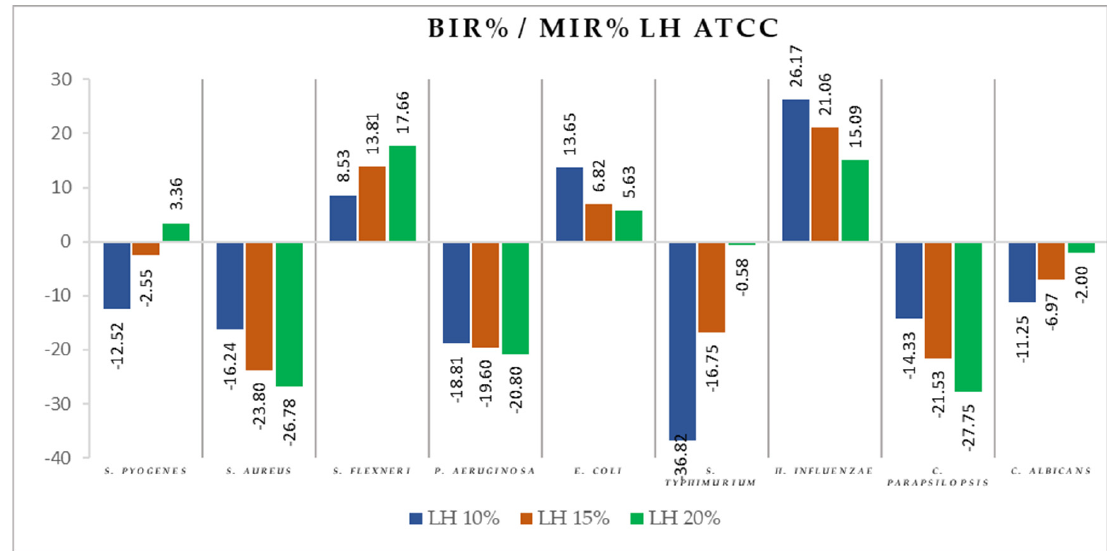
Figure 7. LH antimicrobial activity (expressed as BIR%/MIR%) on ATCC strains. Comparing the BIR percentages, the most sensitive ATCC strains in the case of the MH samples were H. influenzae, E. coli , and S. pyogenes (Figure 4). For H. influenzae, the bacterial inhibition rate (BIR%), depending on the concentration tested (MH 10%, MH 15%, and MH 20%), varied from 29.78% to 46.07% (Figure 4). In the case of E. coli, MH proved a bacterial inhibition rate (BIR%) ranging from 3.96% to 33.84% compared to the negative control, and against S. pyogenes, BIR ranged from 20.01% up to 32.27%. MH showed a medium effect on S. aureus , S. typhimurium , and C. albicans , with values up to 20% inhibition at the highest concentration tested and low inhibitory effects against S. flexneri and C. parapsilopsis with inhibitory values ranging up to